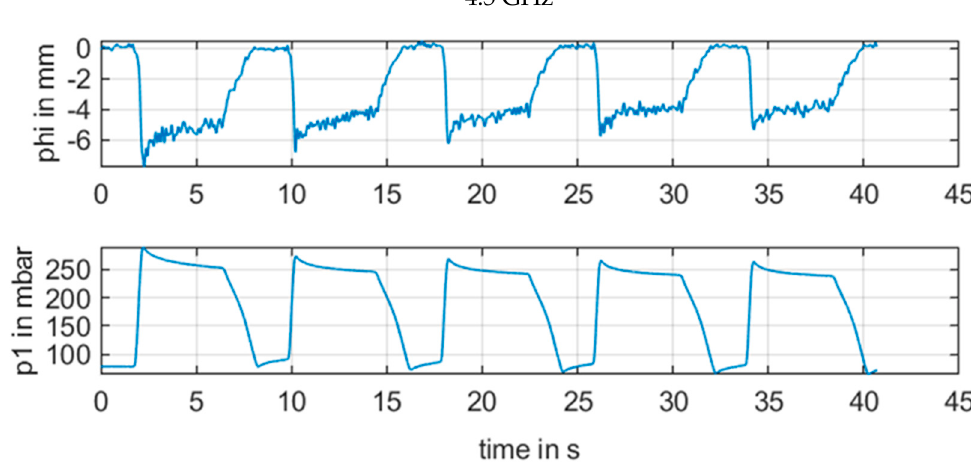
Figure 13. Measurement results for φ m [ mm ] of CW radar with frequency 4.1 GHz in comparison with reference pressure p1 Figure 13. Measurement results for 𝜙 (cid:3040) (cid:4670)mm(cid:4671) of CW radar with frequency 4.1 GHz in comparison with reference pressure Figure 13. Measurement results for 𝜙 (cid:3040) (cid:4670)mm(cid:4671) of CW radar with frequency 4.1 GHz in comparison with reference pressure from pressure sensor. p1 from pressure sensor. p1 from pressure sensor.